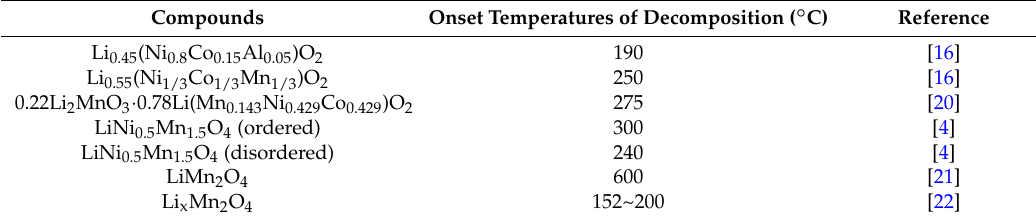
Table 2. Decomposition temperatures of several Mn-based